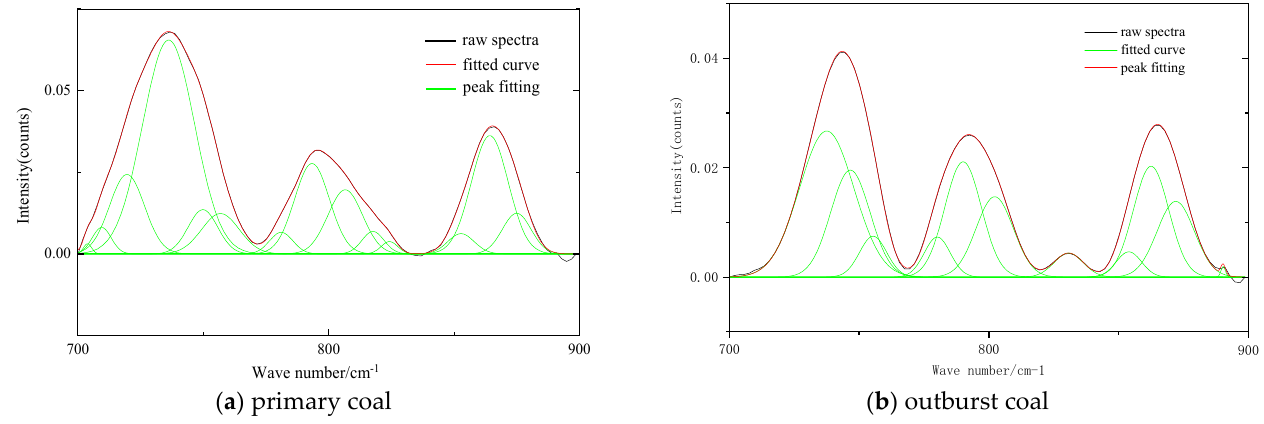
Figure 3. FTIR Spectra of Aromatic Structure.